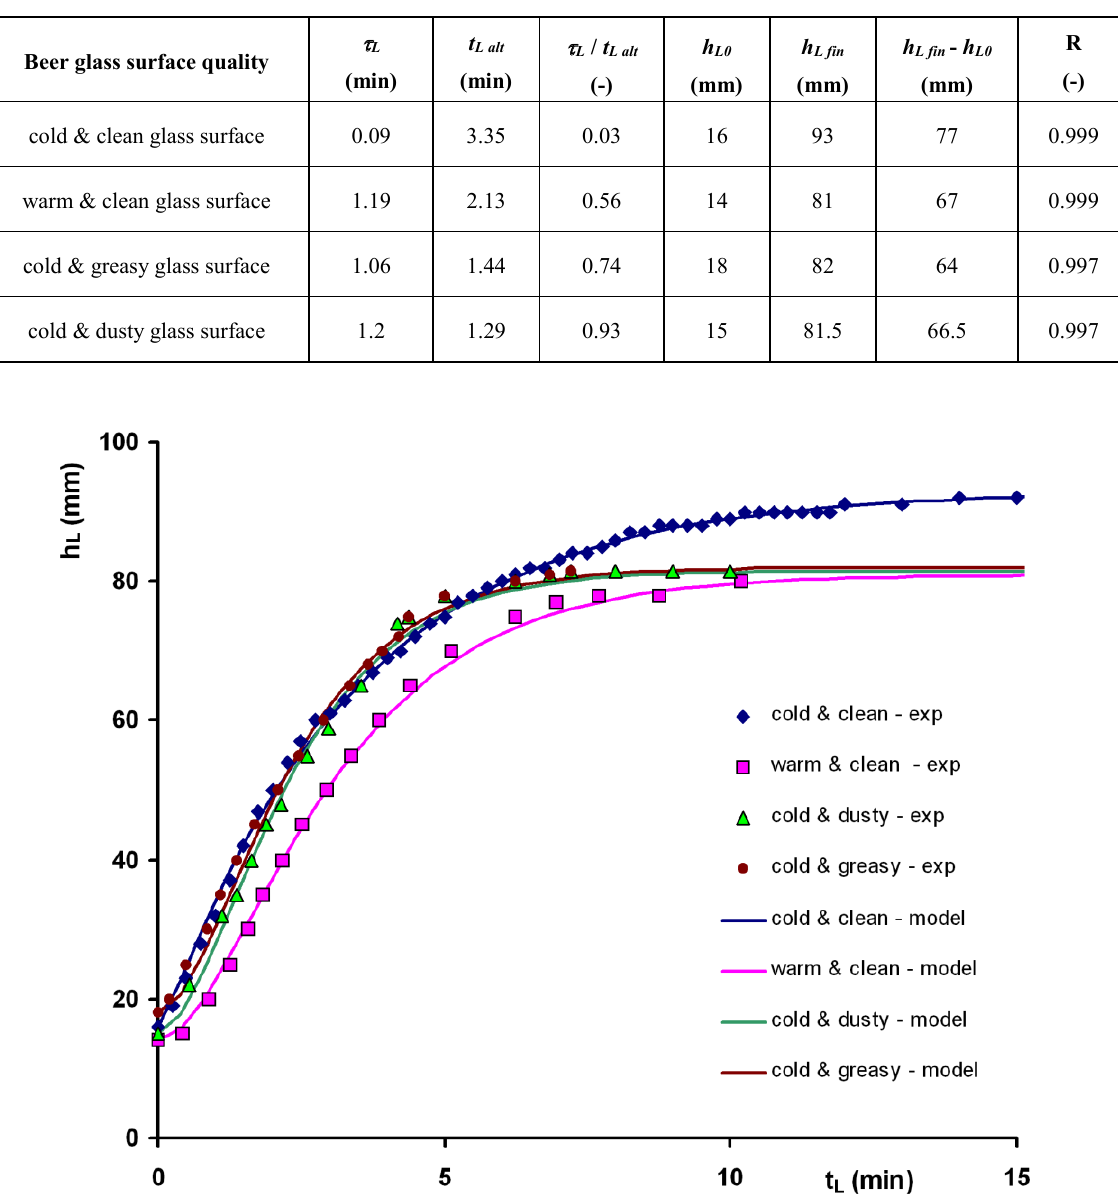
Table 2. Liquid formation - effect of beer glass surface quality.